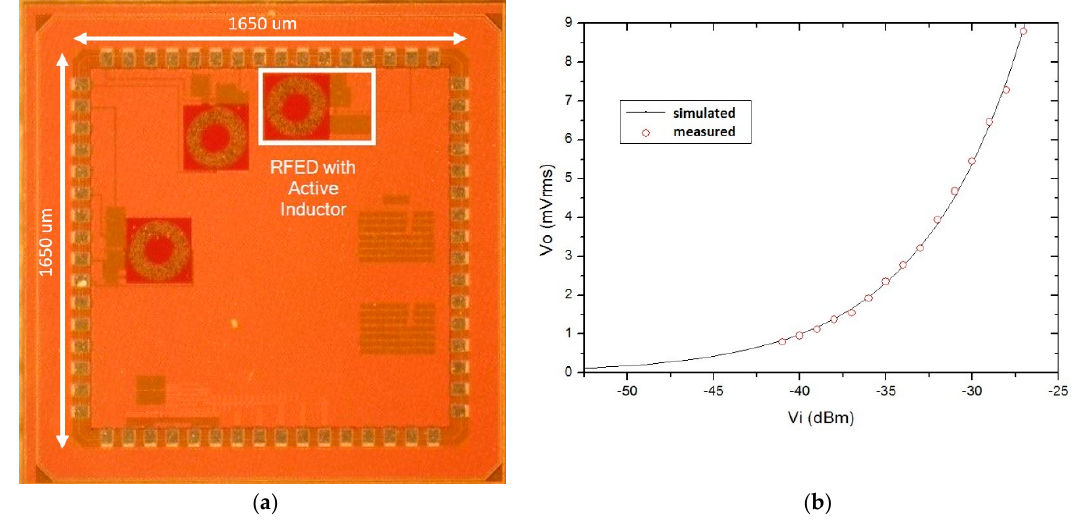
Figure 11. Layout ( a ) and measured sensitivity ( b ) of the RFED WuR with preamplifier and active inductor.